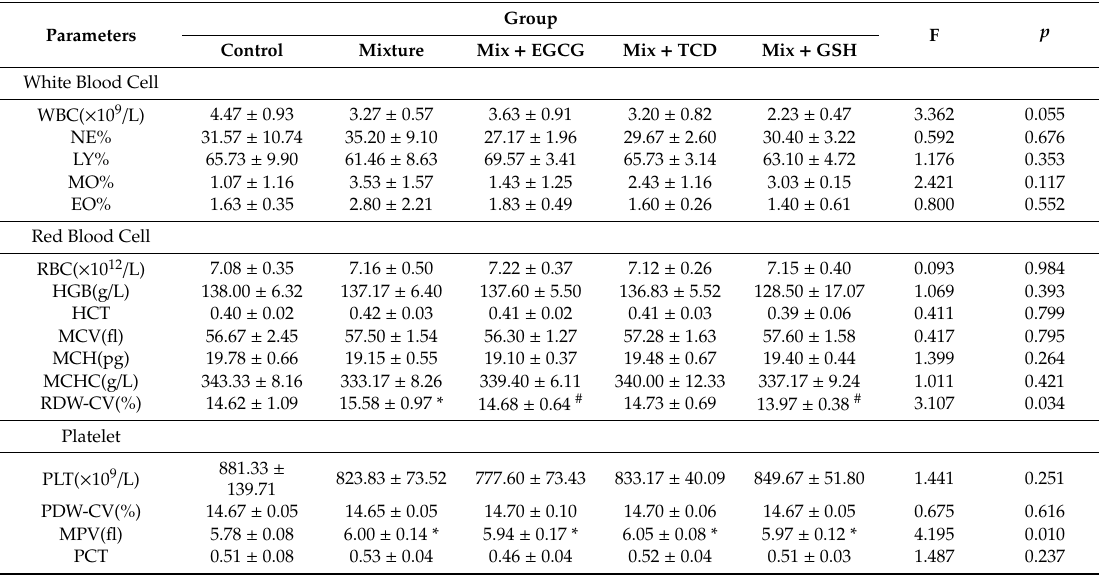
Table 4. E ff ects of the heavy metal mixture on the hematological parameters with or without the addition of chemical antagonists ( n = 30).